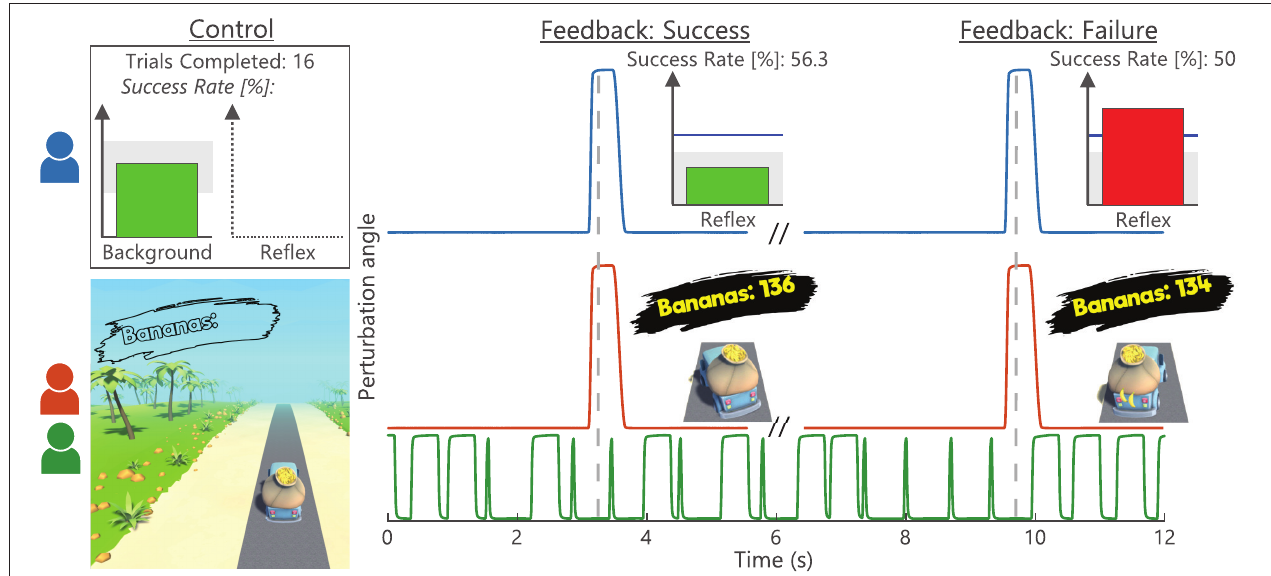
FIGURE 2 | Biofeedback visualization and timing. For the ( blue ) Conventional group, a background (all trials) and a reflex (conditioning trials only) bar-graph directly represented current magnitudes. Moreover, a ( gray ) target area was displayed with the bar color visualizing whether this target was met ( green ) or not ( red ) ( 7). The reflex graph also showed a blue reference line based on average baseline (B1-5) reflex magnitude. The reflex biofeedback ( gray-dashed vertical) was coupled to a stretch perturbation, displayed after a short data processing delay. Additionally, the completed number of trials and success rate were displayed. The game-based Gaming ( red ) and Impedance ( green ) groups had truck left-right position represent current background magnitude with the ( gray ) road as target area. Reflex activity controlled the number of bananas in the trunk after each feedback instance, visualized as wobble of the truck. After the wobble, all bananas were retained when the (non-visual) reflex target was met and two bananas would fall out on failure. As a result, the continuous perturbations of the Impedance group were decoupled from the feedback